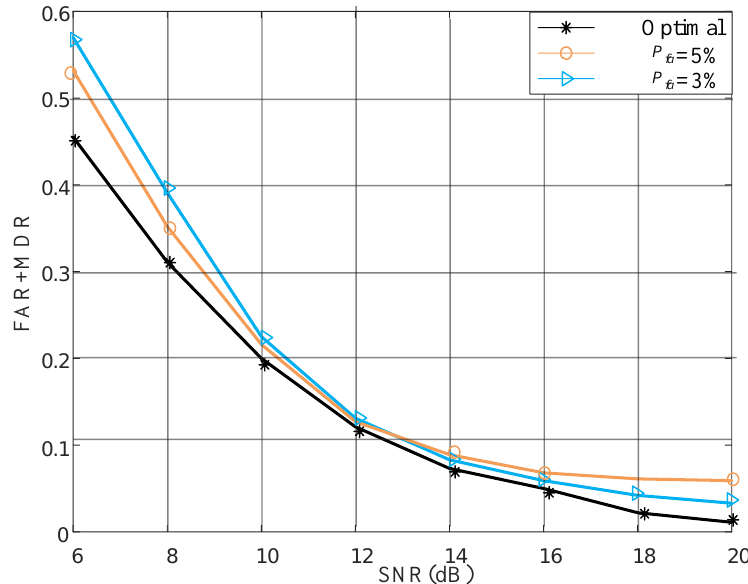
meets its physical meaning. In addition, two curves with different FARs intersect, since at low SNR, the difference between legal and illegal transmitter is small, causing MDR to go down as FAR goes up, and this is the opposite case when SNR is high.